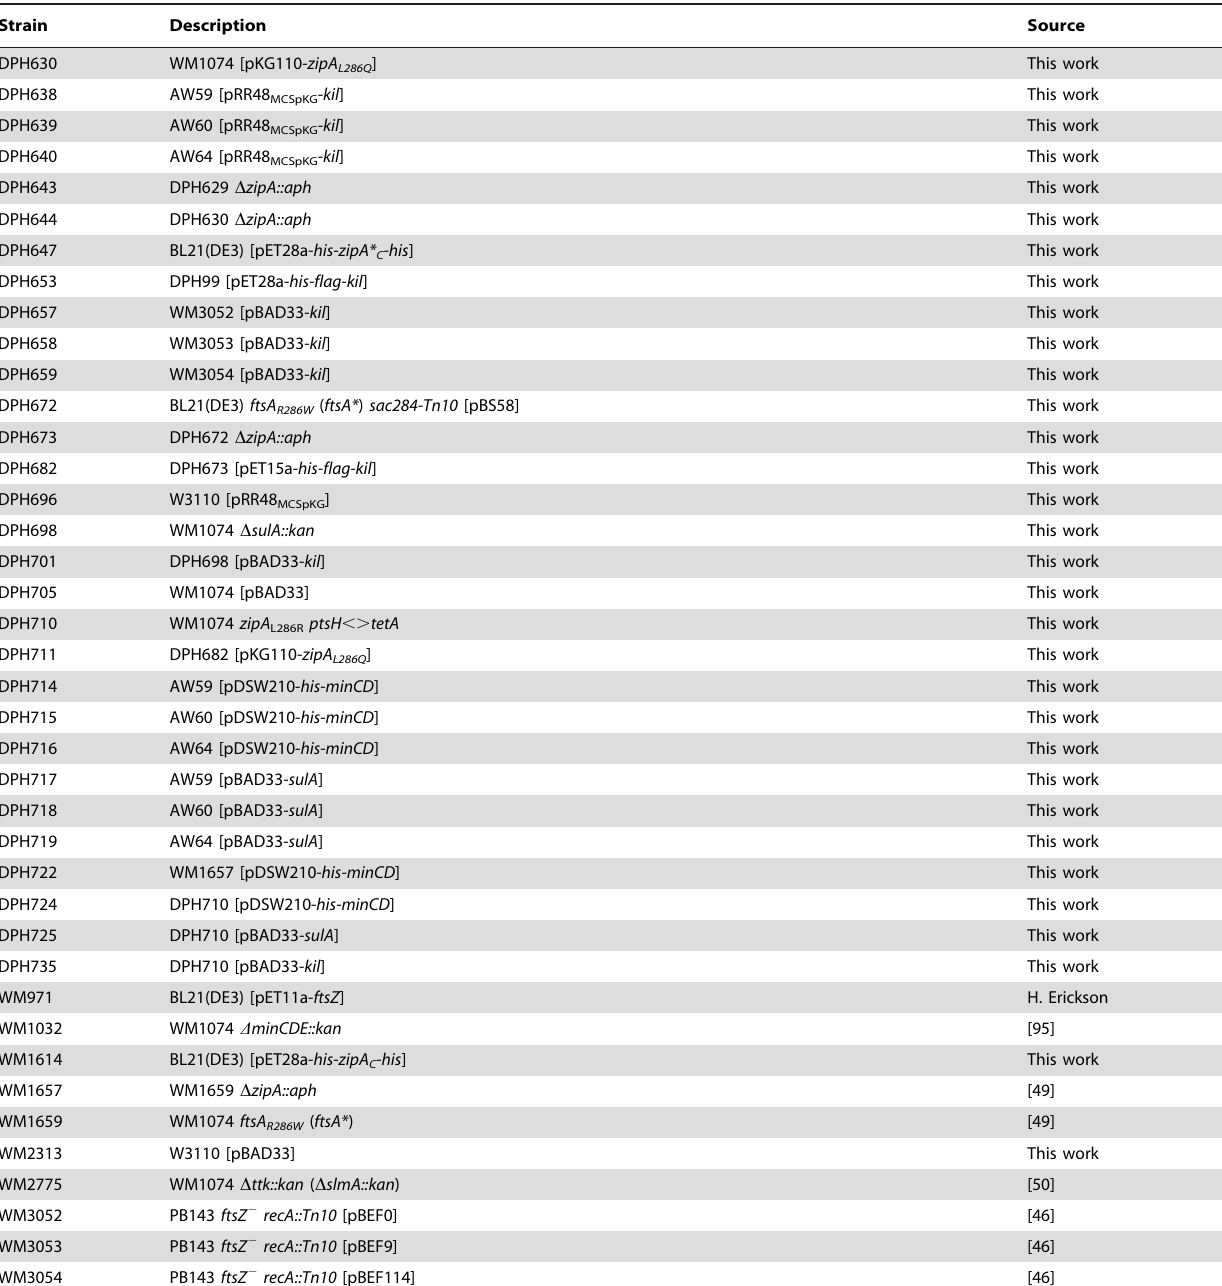
Strain Description